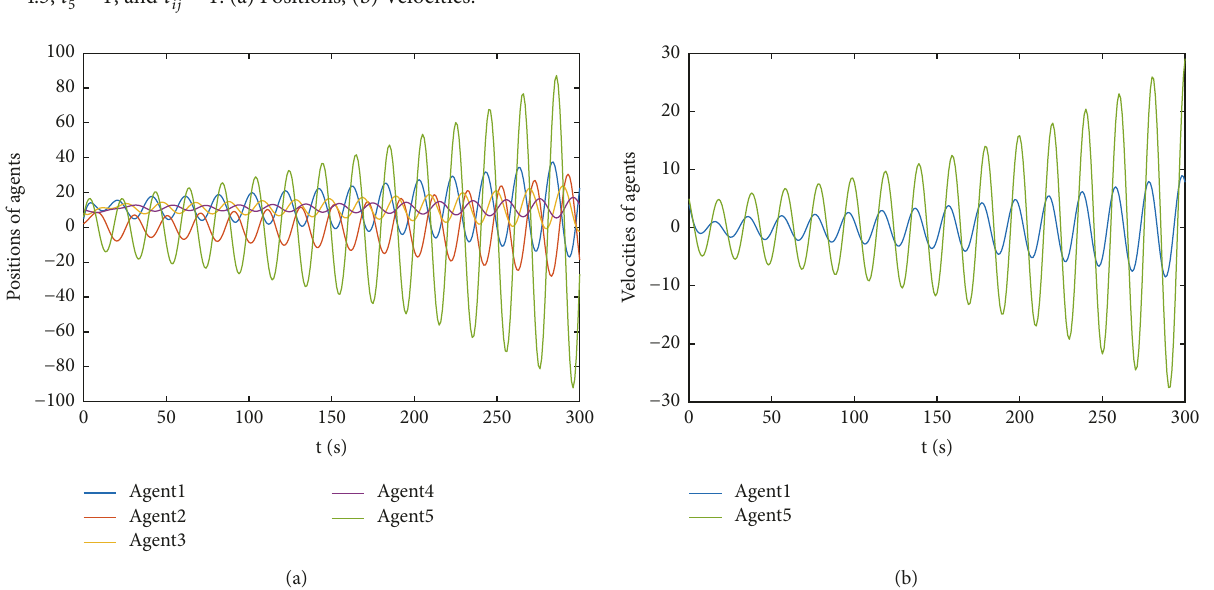
Figure 7: The state trajectories of the agents under directed topology in Figure 5 with different input time delays 𝜏 1 = 1 , 𝜏 2 = 4.5 , 𝜏 3 = 4.5 , 𝜏 = 4.5, 𝜏 = 1 , and 𝜏 = 1 . (a) Positions, (b) Velocities. 4 5 𝑖𝑗